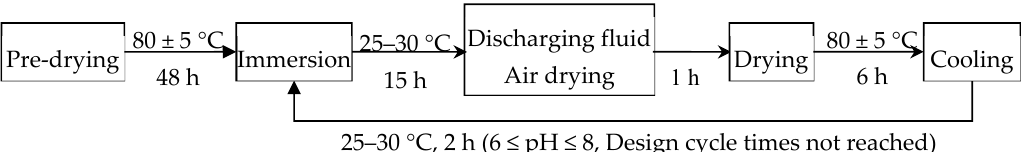
Figure 2. The procedure of the wetting–drying (W-D) cyclic experiment.